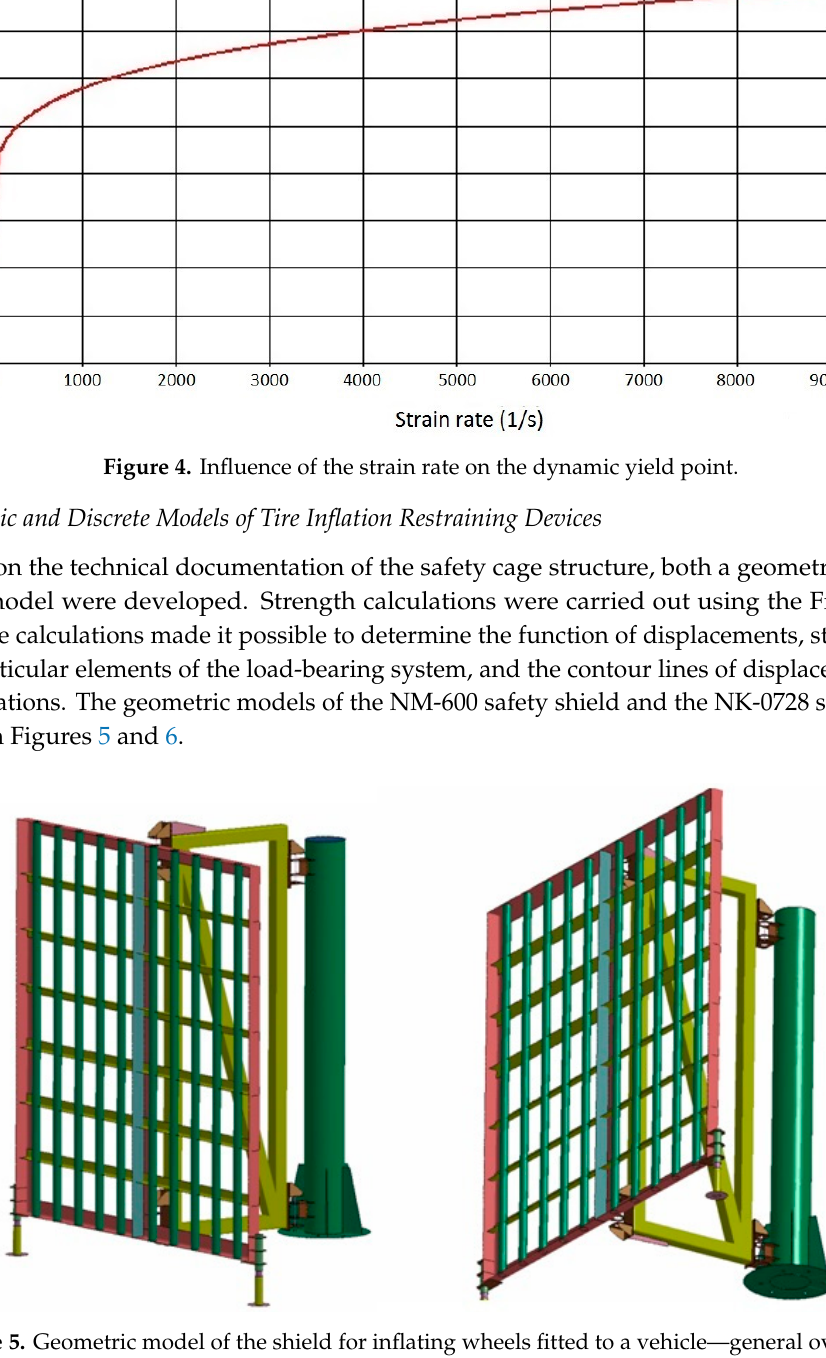
Figure 5. Geometric model of the shield for inflating wheels fitted to a vehicle—general overview.